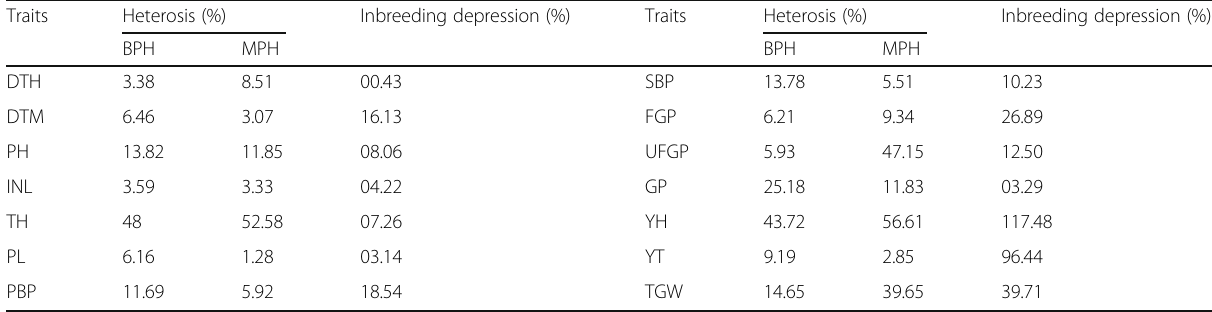
Table 2 Estimates of heterosis as deviation from mid-parent (MP) and better parent (BP) and inbreeding depression (%) for yield and contributing traits Traits Heterosis